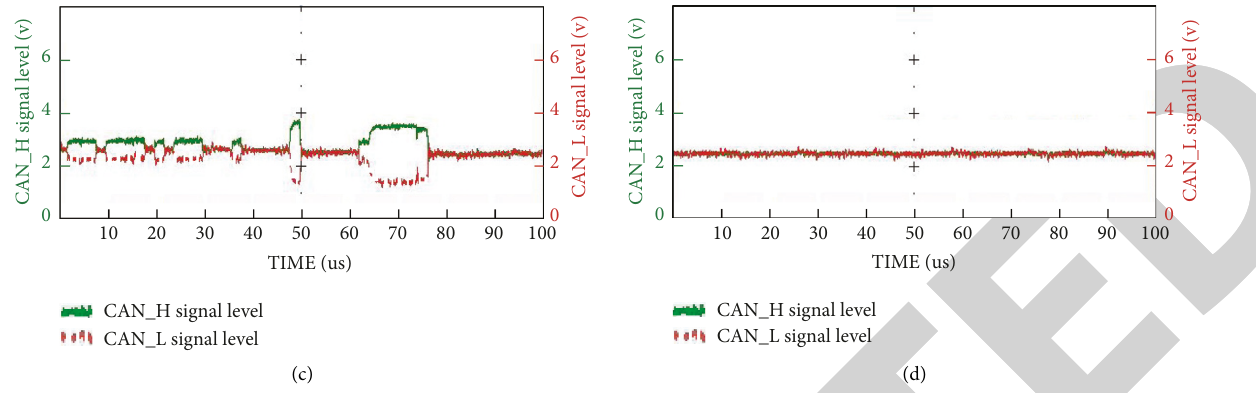
Figure 7: Signal waveform between CAN_H and L loaded with different resistances. (a) Loading 75 Ω between PT-CAN_H and L. (b) Loading 37 Ω between PT-CAN_H and L. (c) Loading 15 Ω between PT-CAN_H and L. (d) Loading 0 Ω between PT-CAN_H and L.